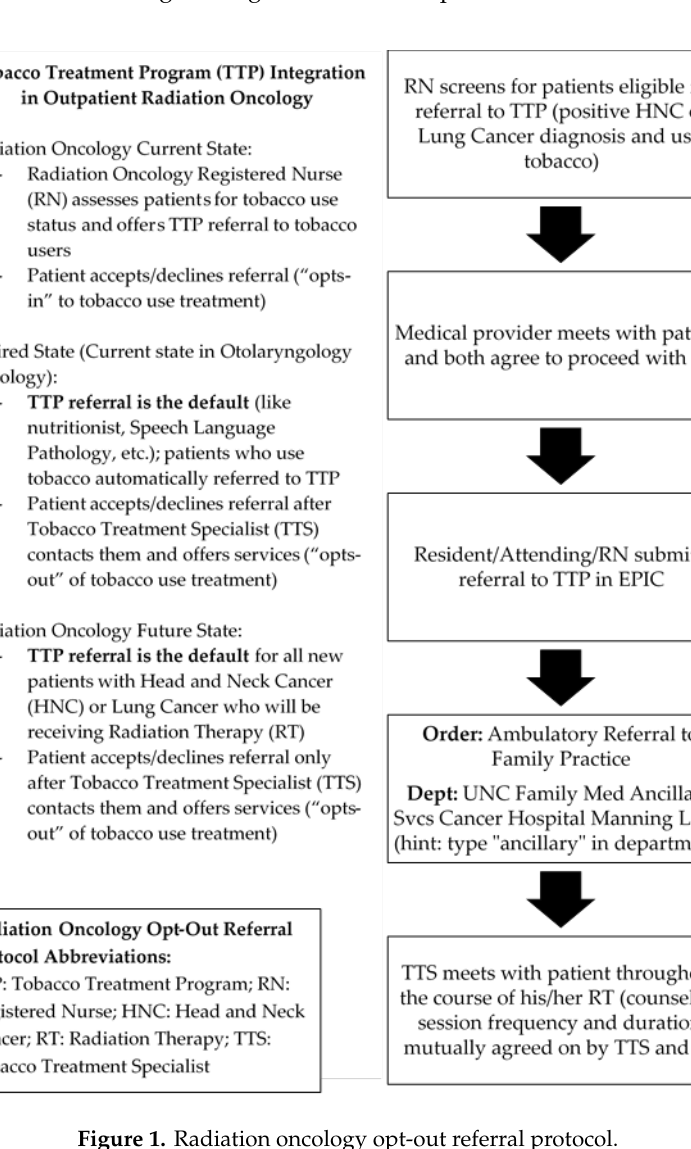
Figure 1. Radiation oncology opt-out referral protocol.